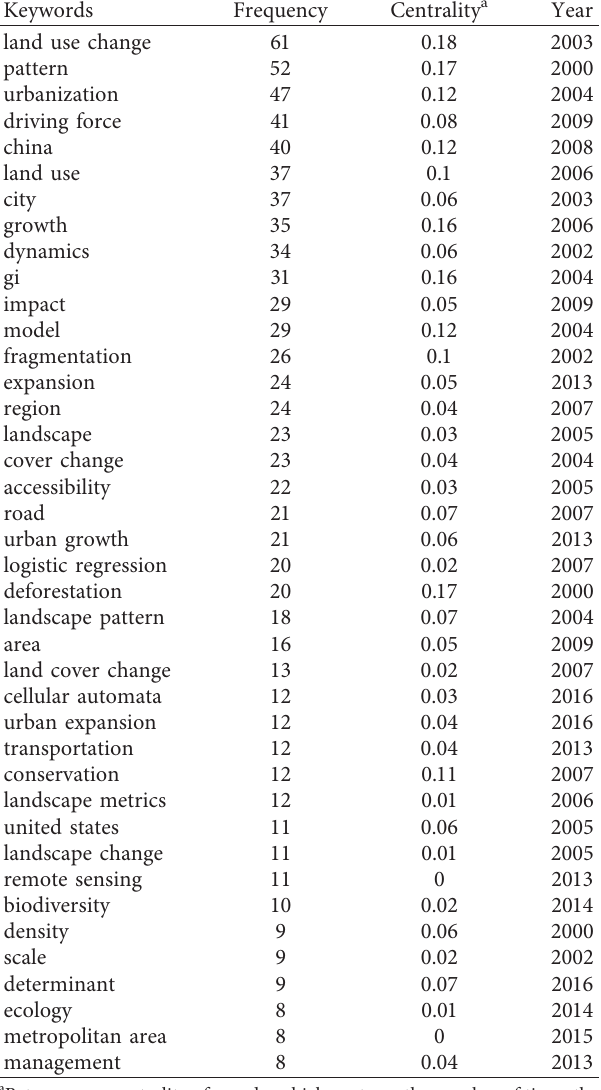
Table 2: Statistics on high-frequency